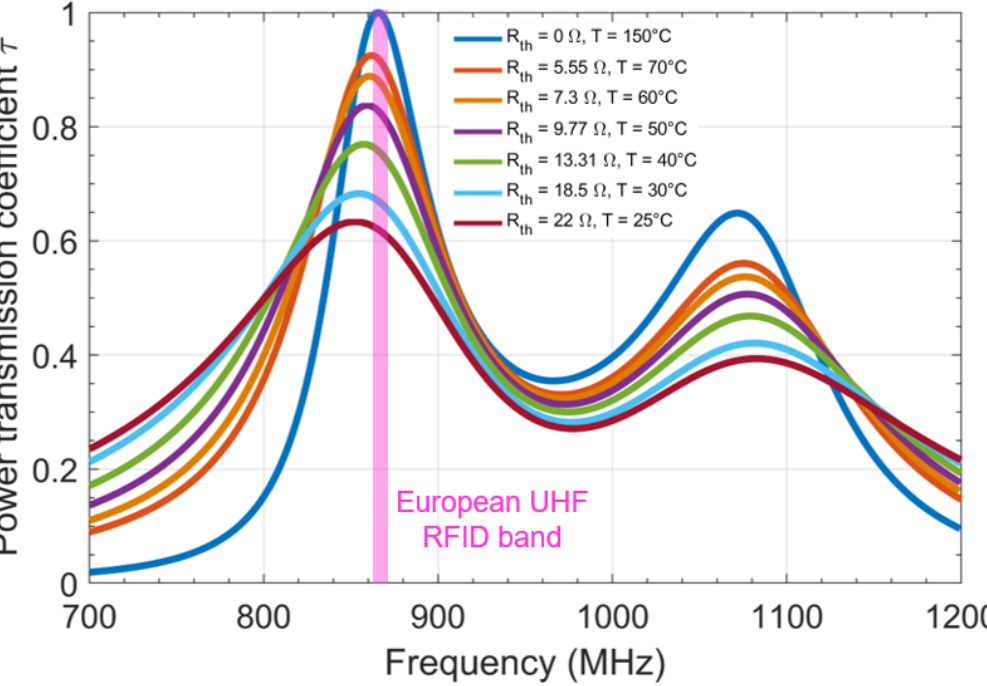
Figure 2. Impact of the thermistor’s resistance change due to temperature on the RFID sensor tag.